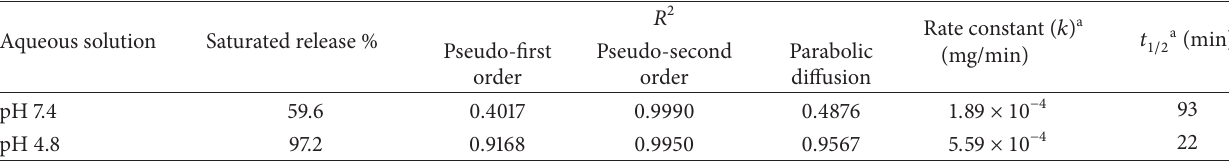
Table 2: Correlation coefficient, rate constant, and half-time obtained by fitting the data of the release of MP from FPEGMP-2 nanocomposite into phosphate-buffered solution at pH 4.8 and 7.4.